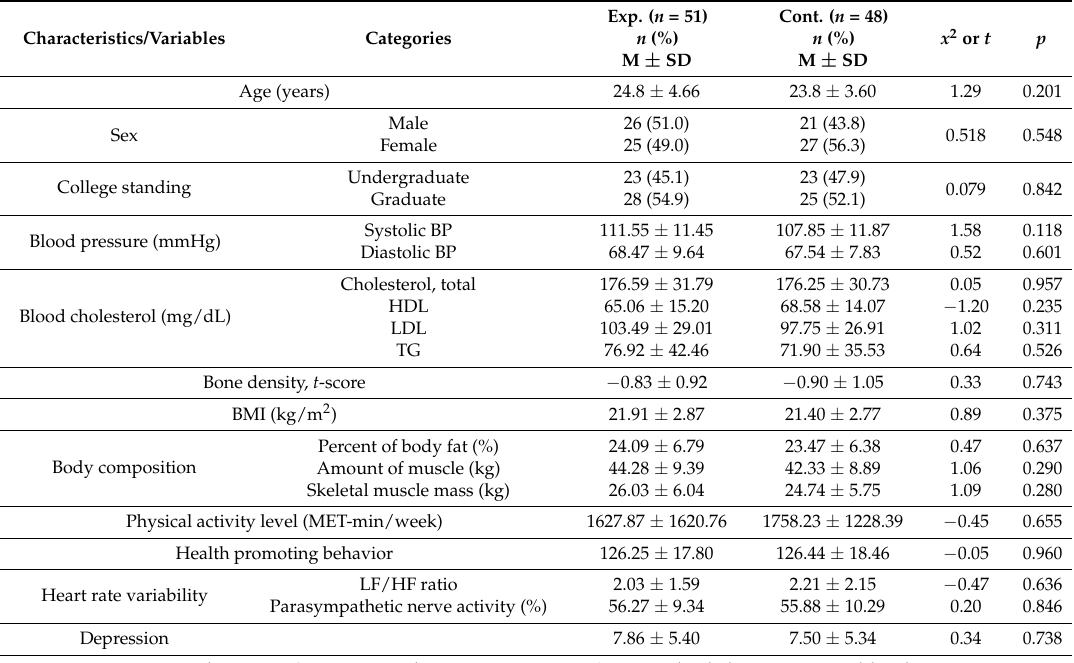
Table 1. Homogeneity test of participants’ general characteristics and outcome variables during the pre-test ( N =